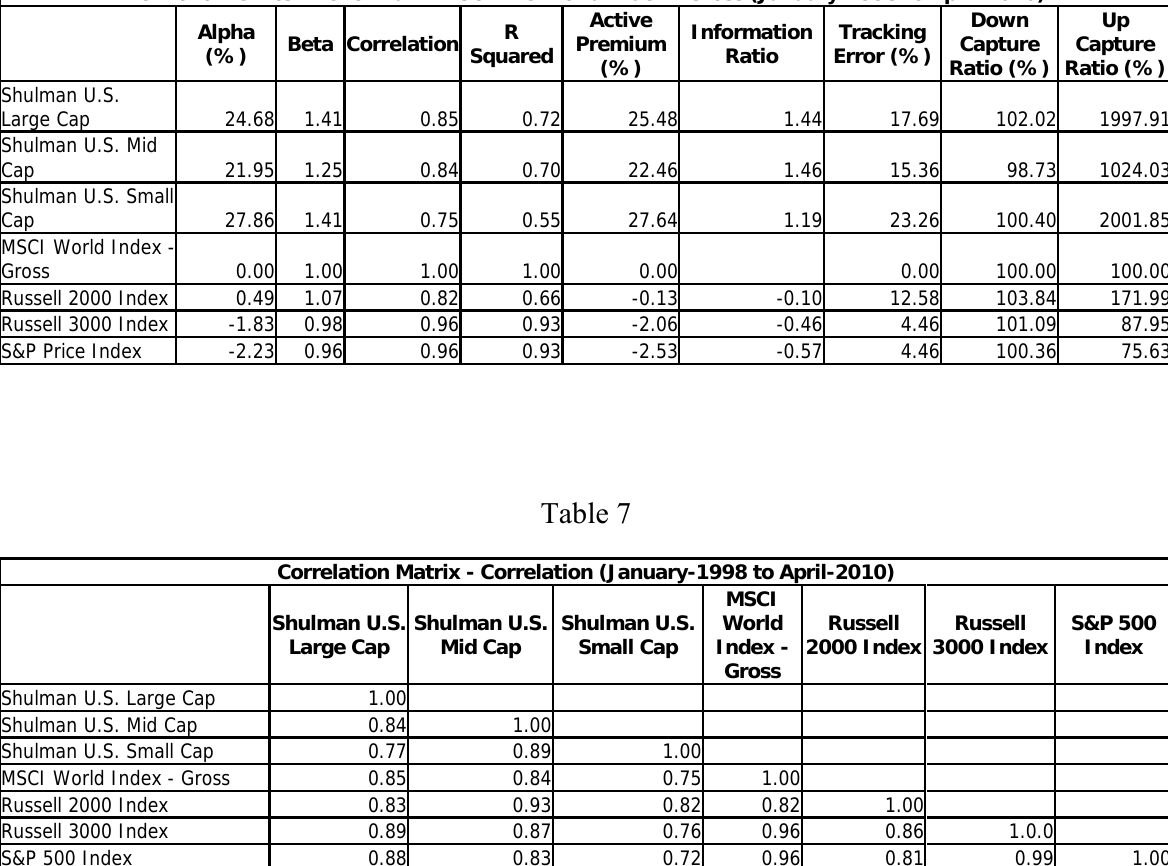
Portfolio Metrics - Benchmark: MSCI The World Index - Gross (January-1998 to April-2010)